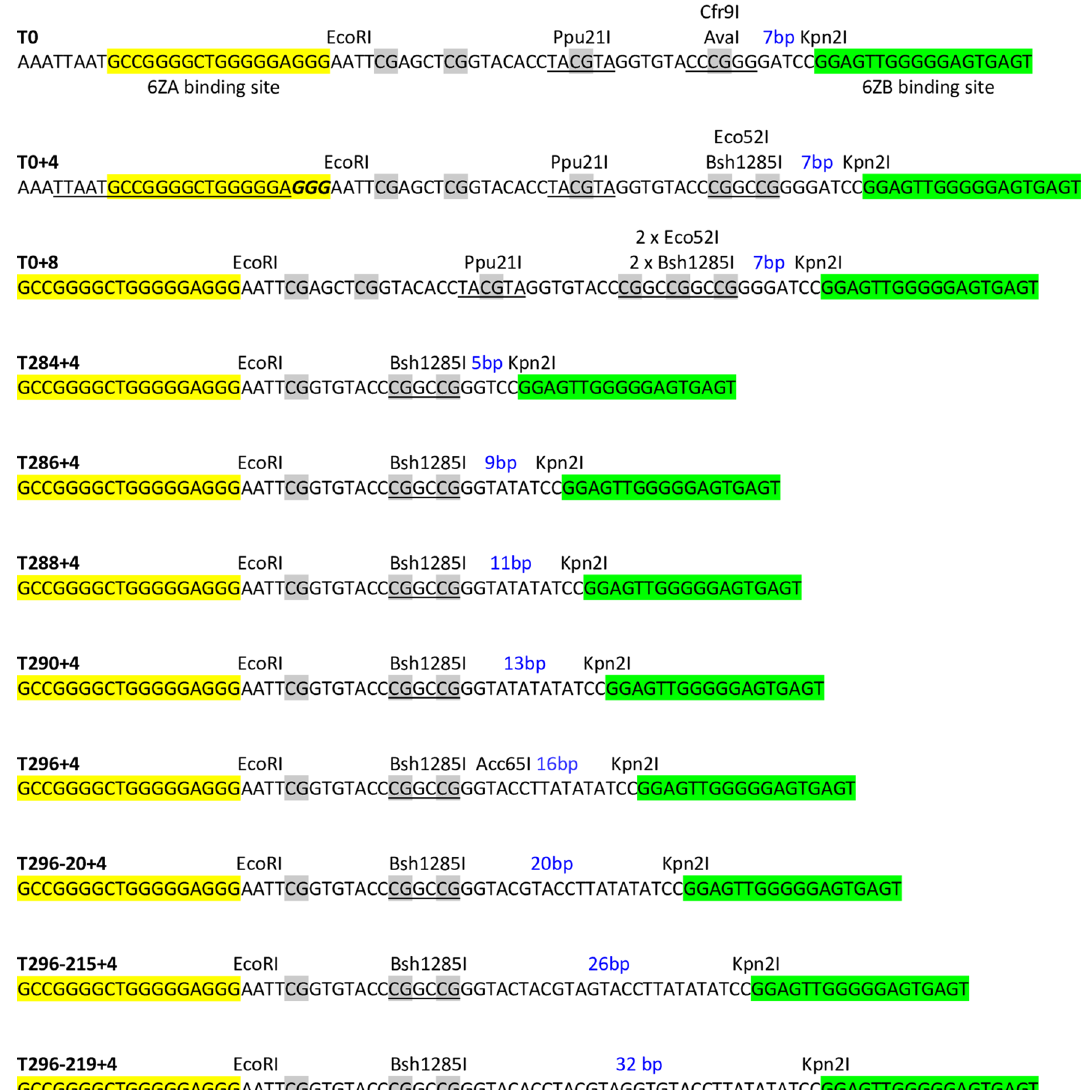
Figure 1. Nucleotide sequence of the target regions containing a Bsh1285I site. The original T0 target region containing the AvaI site is shown at the top. Yellow and green highlighting indicates the 6ZA and 6ZB zinc finger binding sites, respectively. The dCas9 binding site determined by the AK735-AK736 oligonucleotide duplex and overlapping the 6ZA binding site is shown in the T0+4 sequence: the protospacer is underlined and the PAM is in italic. The CG sites located between the ZF binding sites are highlighted by grey background. The blue numbers indicate the distance between the 6ZB binding site and the closest